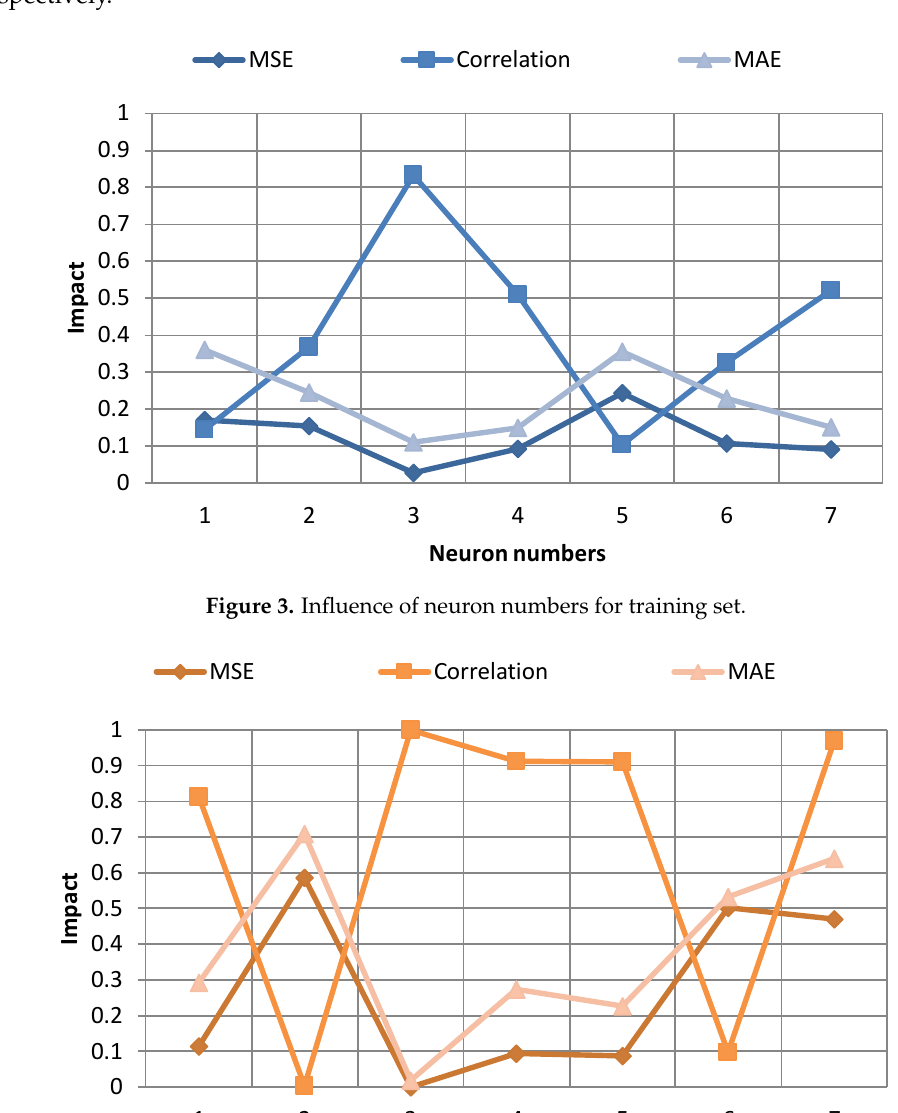
Figure 4. Influence of neuron numbers for test set.